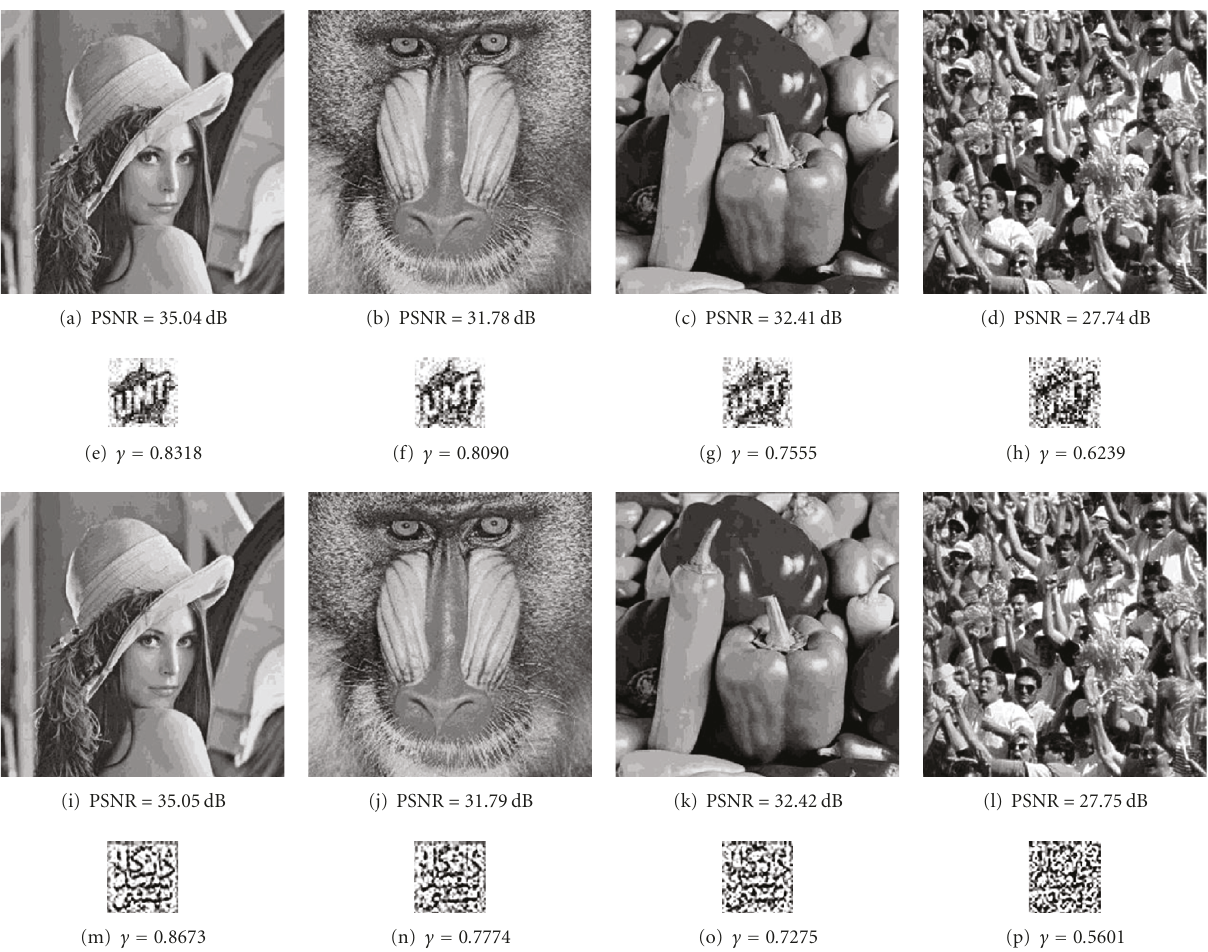
Figure 15: (a)–(d) The watermarked Lena, Baboon, Peppers and Crowd images with 128 × 128 watermark image as shown in Figure 11(b) after JPEG compression with quality factor 40%, 30%, 20% and 10%, respectively. (e)–(h) The extracted watermarks (128 × 128) from (a)–(d), respectively. (i)–(l) The watermarked Lena, Baboon, Peppers and Crowd image with 128 × 128 watermark images as shown in Figure 11(d) after JPEG compression with quality factor 40%, 30%, 20% and 10%, respectively. (m)–(p) The extracted watermarks (128 × 128) from (i)–(l),